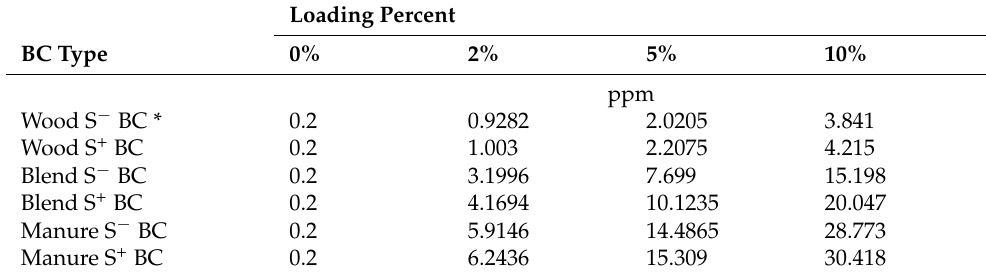
Table 5. Initial soil zinc concentrations in ppm for Trifolium incarnatum .